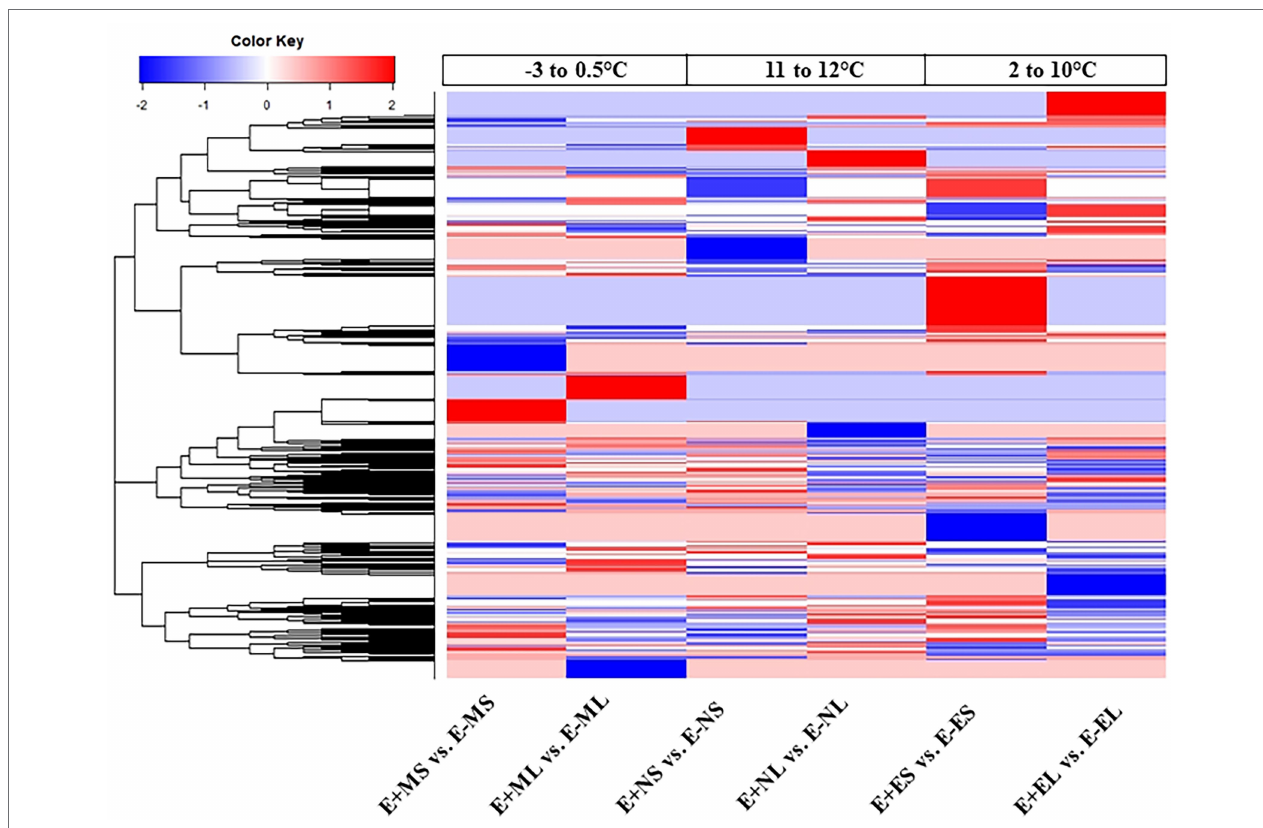
FIGURE 3 | Hierarchical clustering analysis of all differentially expressed genes from six comparisons. Each column represents a different sample with subject to endophyte status, cold stress, and tissue type. Red represents upregulated; blue, downregulated; and white, no change. Abbreviations of the samples are the same as in Figure 1